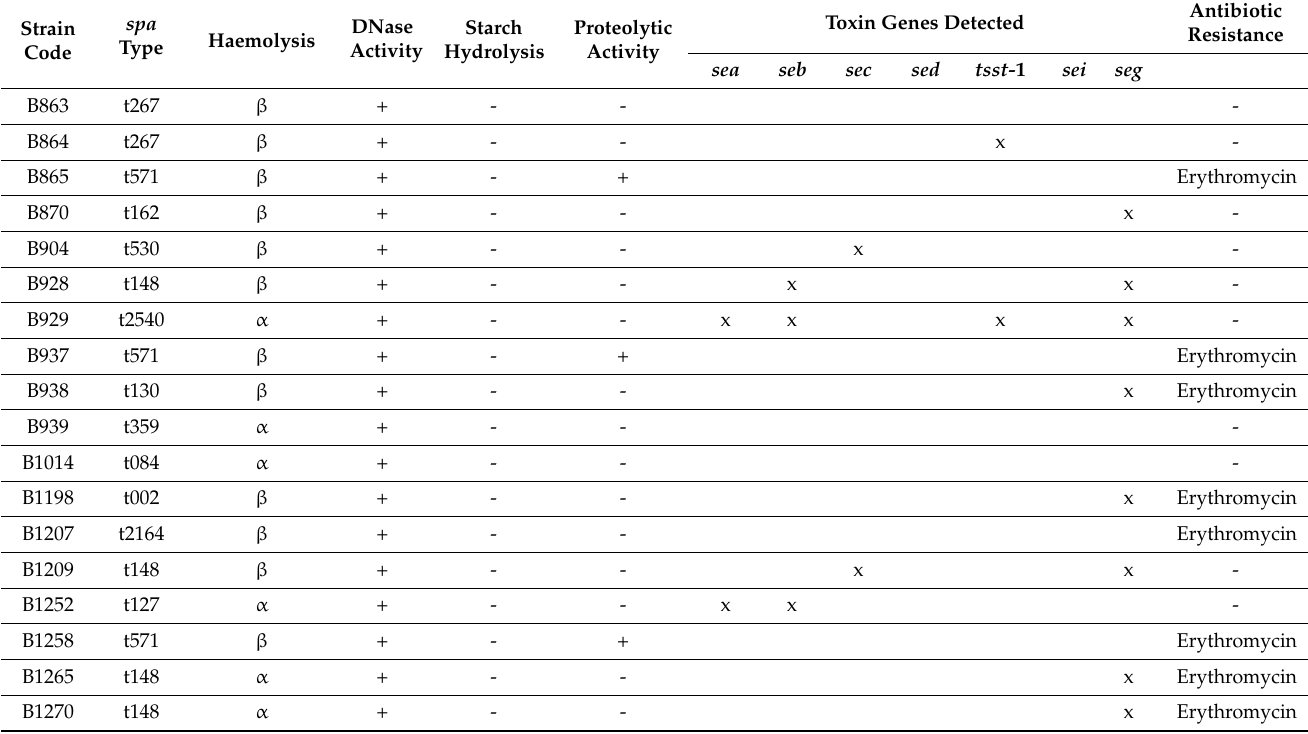
Table 2. Characterisation of the S. aureus